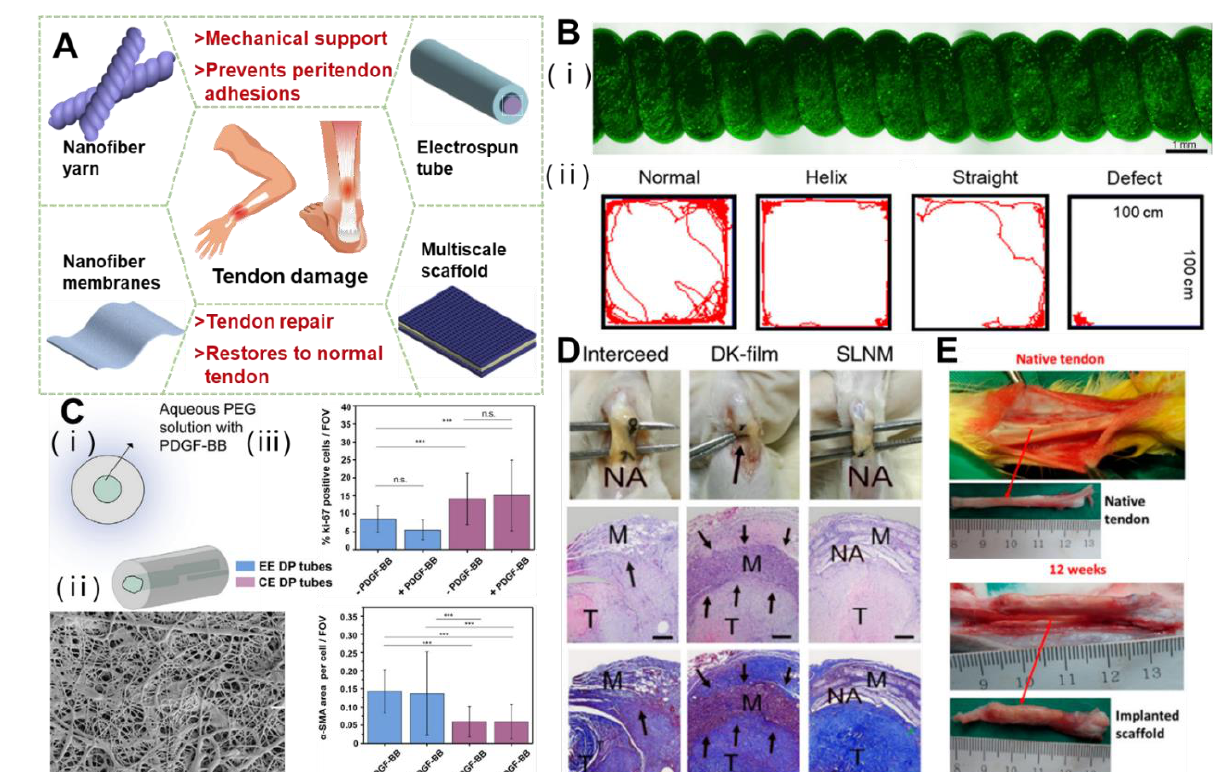
Figure 2. Functional electrospinning products of 3D structures and the effect on tendon repair. ( A ) Schematic diagram of electrospinning for various tendon repair. ( B ) The helical scaffolds are biocompatible and restore motor function in the rat Achilles tendon . Reprinted with permission from Ref. [19]. Copyright 2022 Elsevier Inc. ( C ) Characterization of coaxial electrospun bilayer tubes, which promote recruitment and proliferation of tendon cells. (*** p < 0.001). Reprinted with permission from Ref. [62]. Copyright 2020 Elsevier Inc. ( D ) In vivo antitissue adhesion properties of the superlubricated electrospun nanofibrous membranes. The black arrows point to adhesion site. Reprinted with permission from Ref. [68]. Copyright 2022 Springer Nature Limited. ( E ) The mPCL- nCol-bFGF implantation promoted tendon regeneration after 12 weeks. Reprinted with permission from Ref. [77]. Copyright 2019 American Chemical Society.